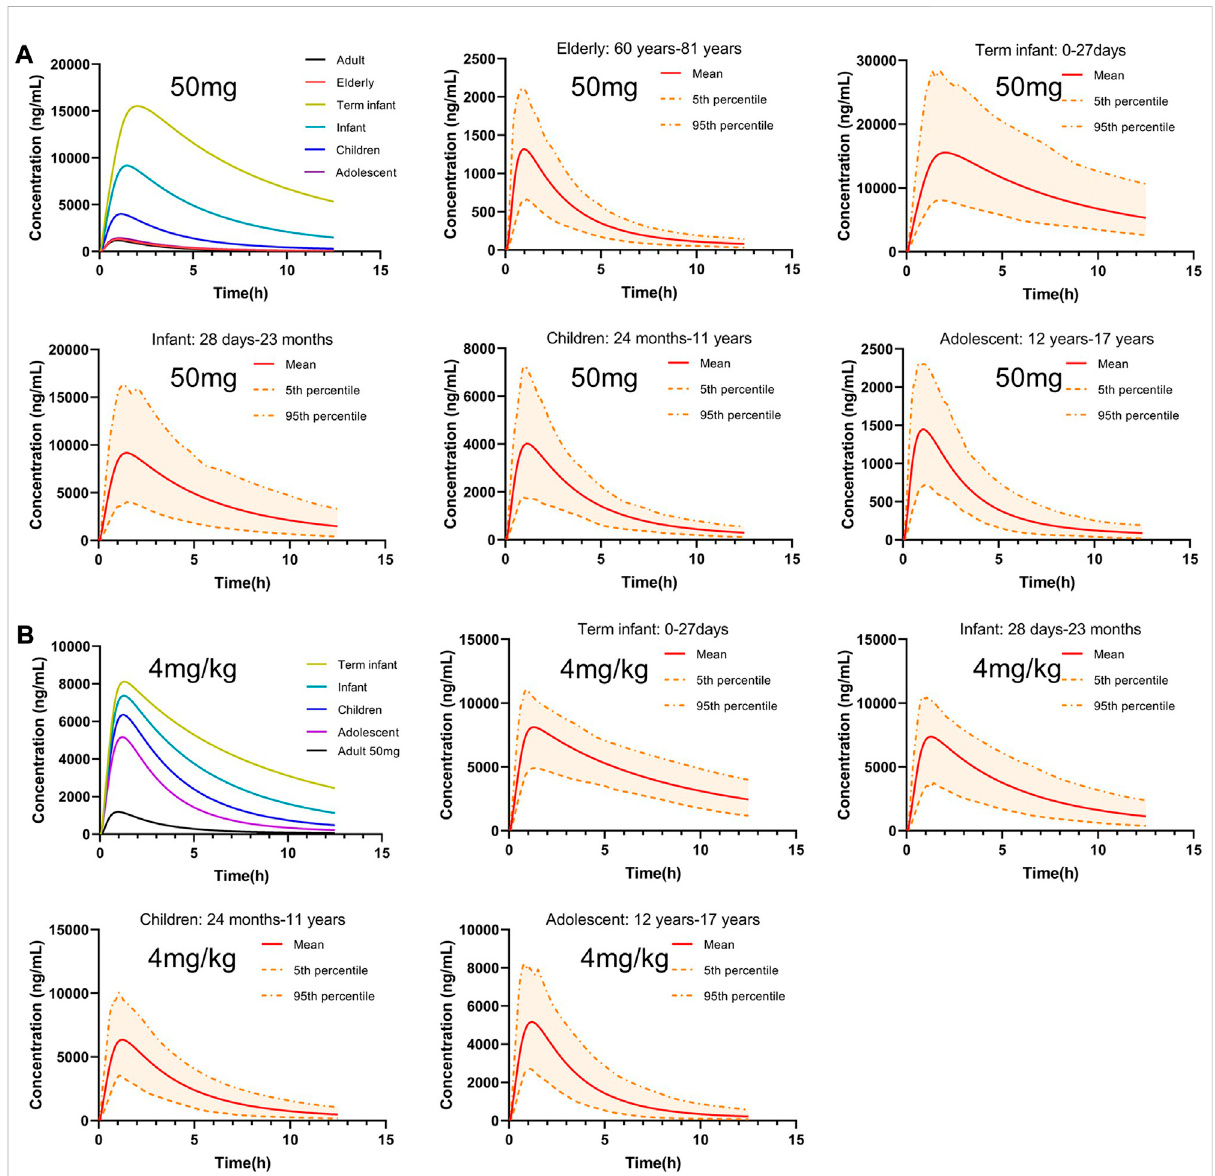
FIGURE 7 Predicted concentration-time pro fi lesafter oraladministrationof50 mgor4 mg/kgPTUinvirtual healthyelderly andpediatricpopulations. (A) Predicted concentration-time pro fi les after oral administration of 50 mg PTU. (B) Predicted concentration time pro fi les after oral administration of 4 mg/kgPTUinvirtualpediatricpopulations.Redsolidline:predictedpopulationmeancurve,yellowdashedlinesandareas:95thand fi fthpercentile predicted values and 90% CI of predicted